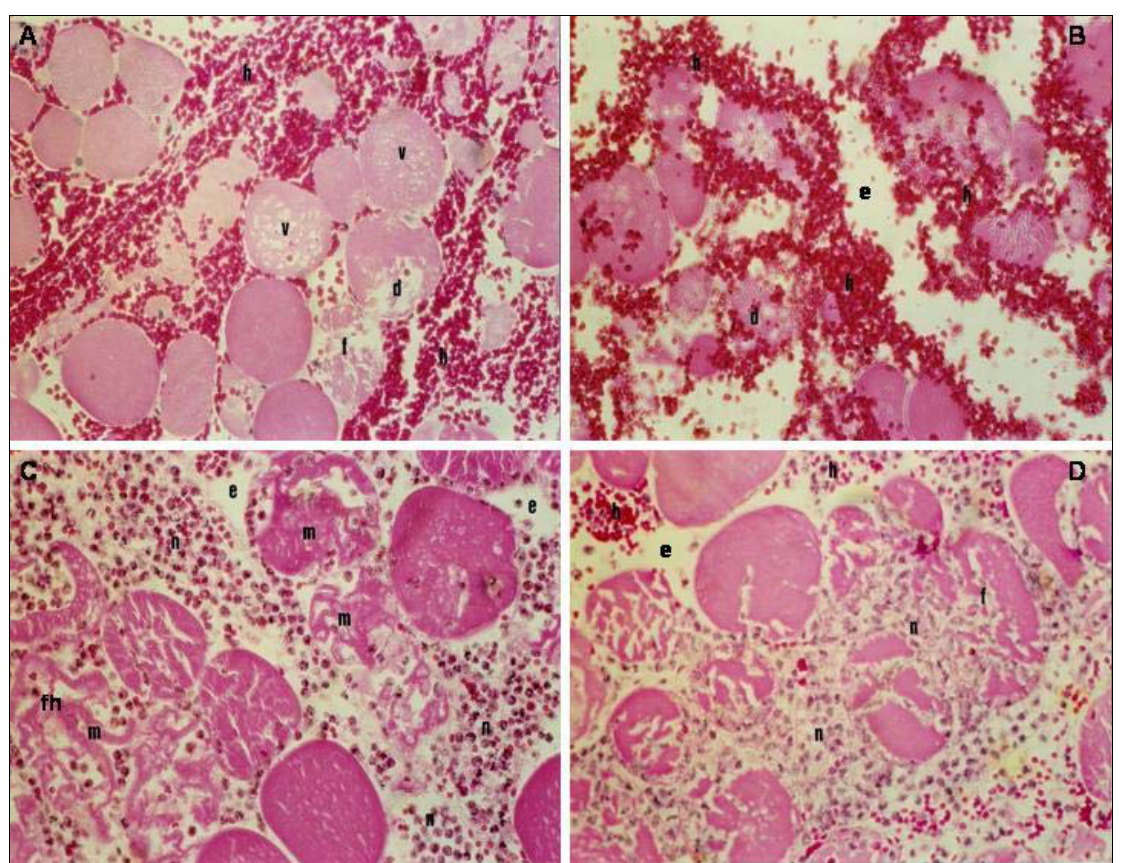
Figure 1. Cross-sections of the gastrocnemius muscle obtained at 3 hours ( A ) and 24 hours ( C ) following injection IM of B. moojeni venom at a dose of 40 µg/mL. In A and C , note areas of necrosis, exsudation of neutrophils (n), hemorrhaging (h), densely grouped myofibrils (m), clear areas in hypercontracted fibers (f) and edema in C . In B and D , cross-sections of the gastrocnemius muscle obtained at 3 hours and 24 hours following IM injection of B. moojeni venom at a dose of 40 µg/mL and irradiated with a laser. Observe the intensive hemorrhaging (h) and muscle fibers at different stages of myonecrosis in B ; and contracted fibers in D , some exhibiting delta lesions (d), ghost cells (gc), densely grouped myofibrils (ma) and others fibers with vacuoles